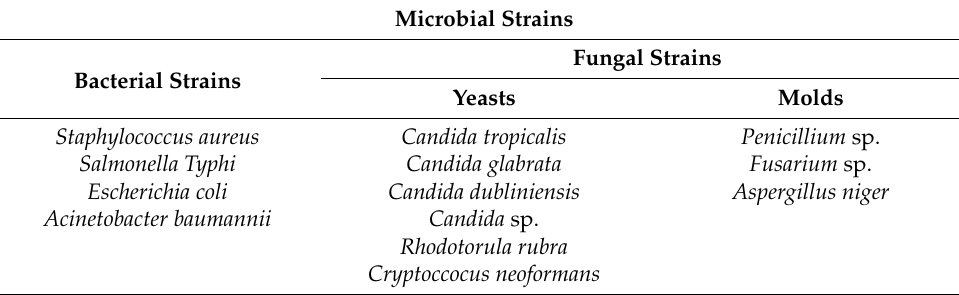
Microbial Strains